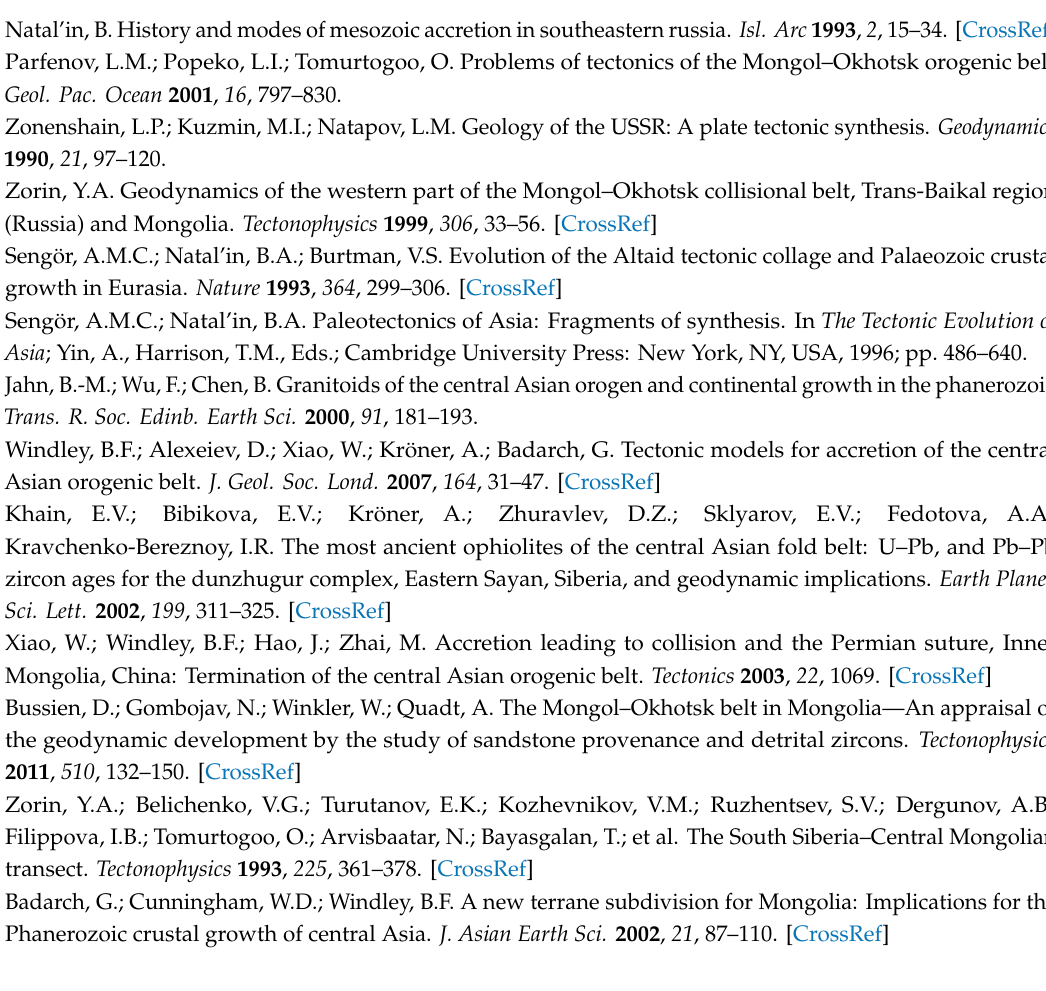
Table S1: U-Pb analytical results of detrital zircon from the Neoproterozoic-Paleozoic sedimentary sequences